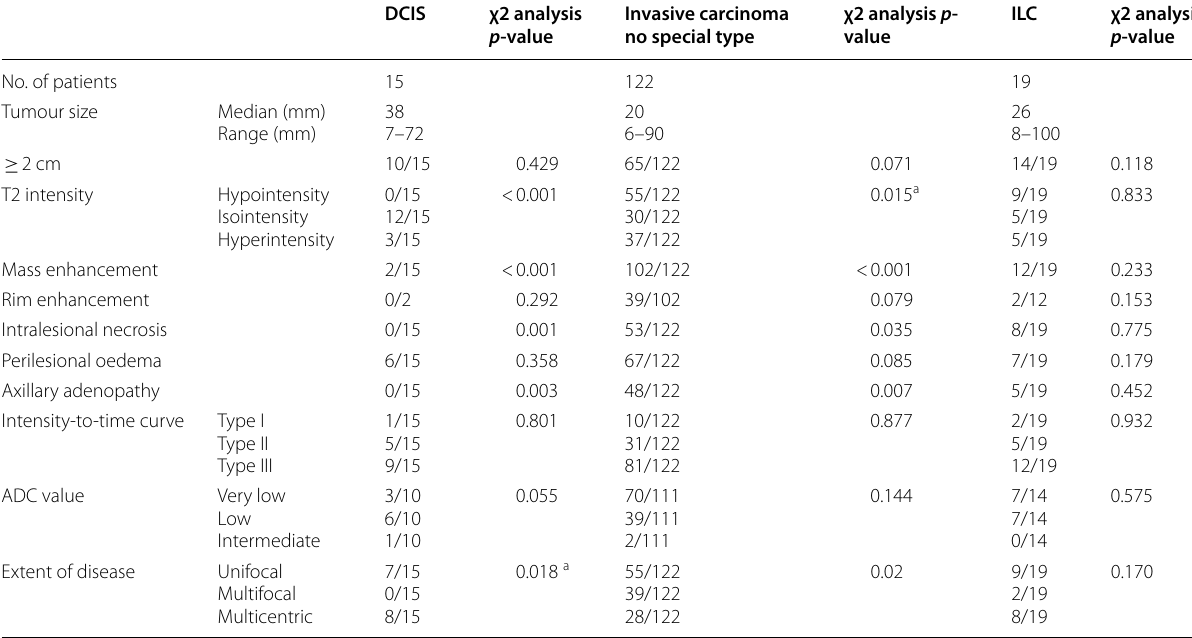
Table 1 Association between histological subtypes of breast